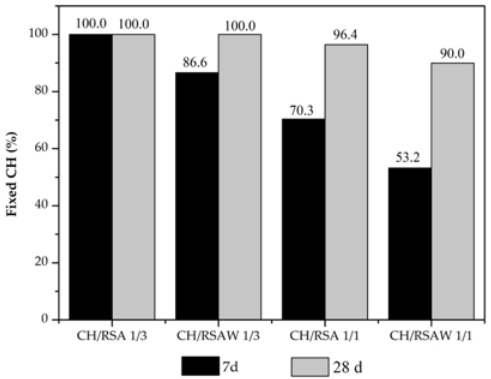
Figure 10. Percentages of fixed CH for pastes CH/RSA and CH/RSAW.